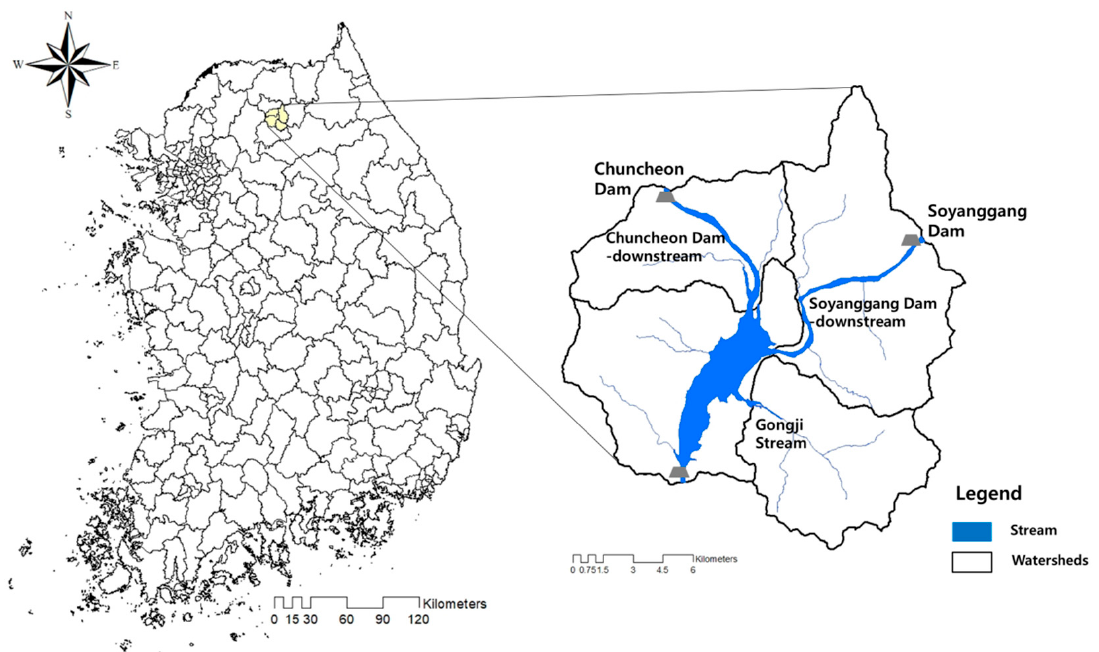
Figure 1. Location of study area : the Uiam Dam basin located in Chuncheon-si, Gangwon-do, in South Korea.